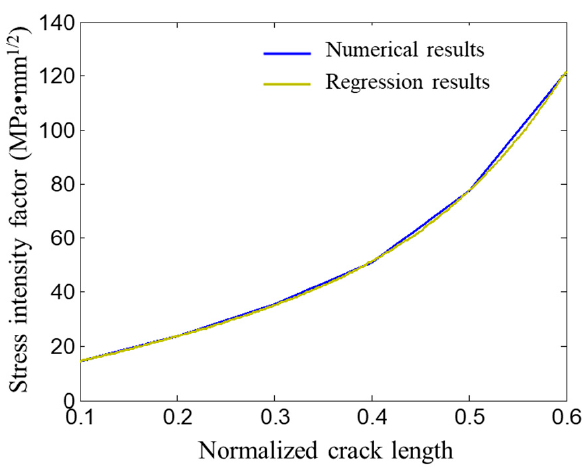
Figure 5. Comparison between numerical and regression results.